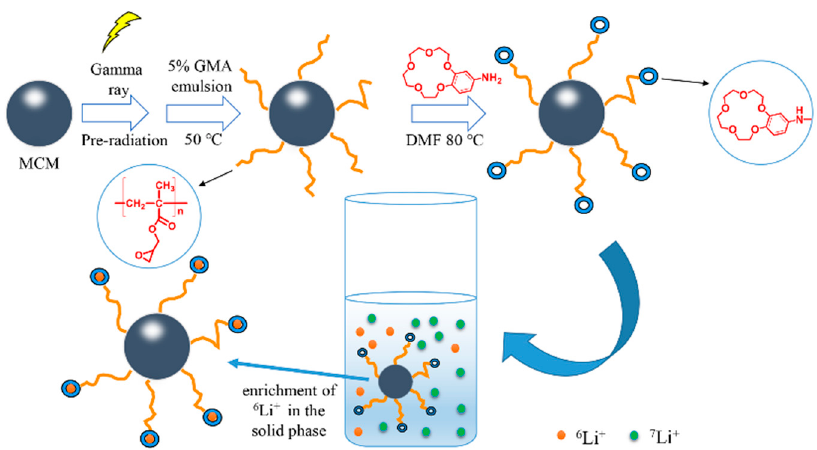
Figure 1. Illustrative synthesis route of MCM- g -AB15C5and expected adsorption process towards lithium isotopes.